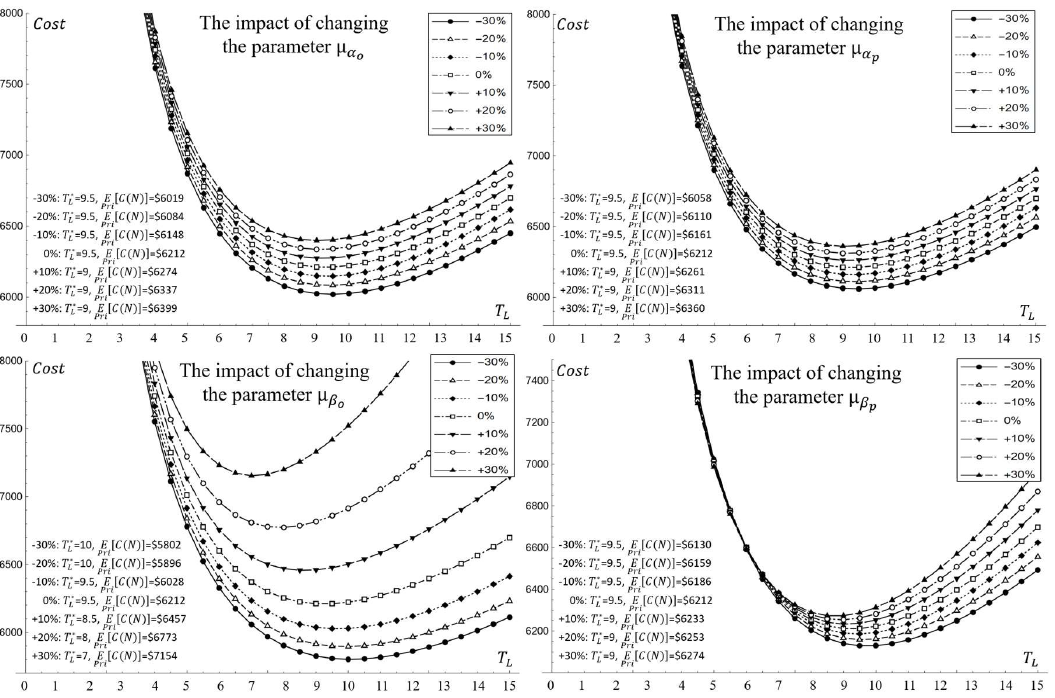
Figure 8. The impacts of 𝜇 (cid:3080)